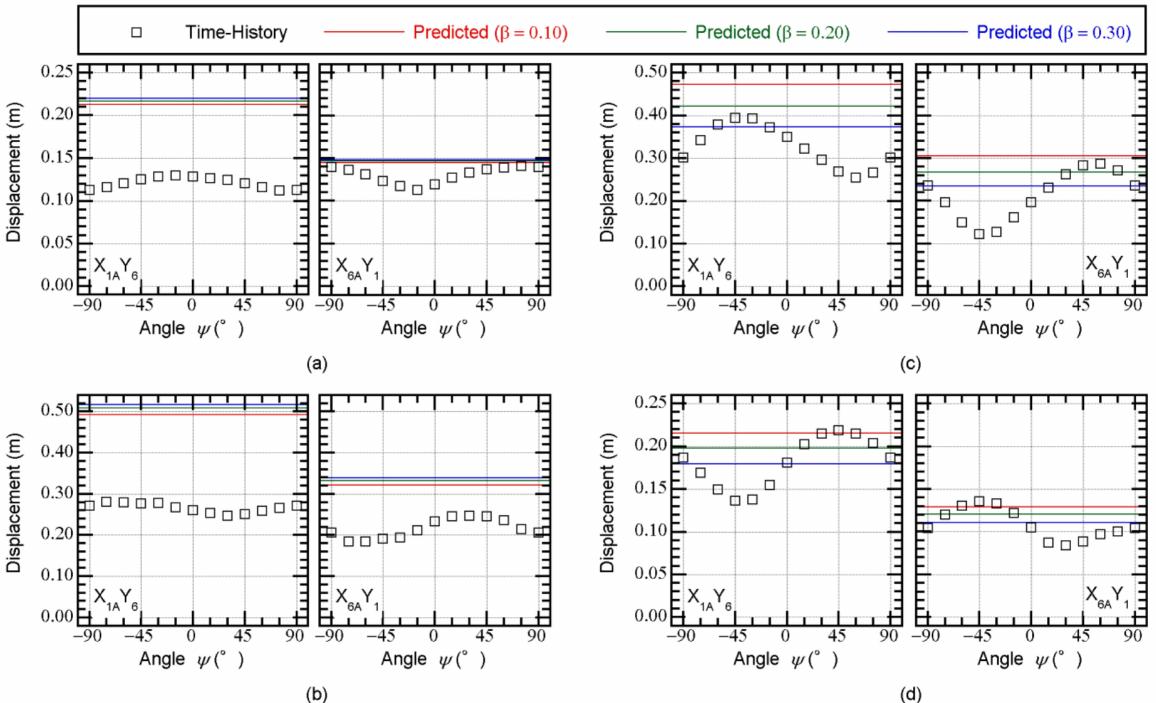
Figure 29. Peak displacement at isolators for various angles of incidence of seismic input (Model-Tf34): ( a ) UTO0414; ( b ) UTO0416; ( c ) TCU; ( d )